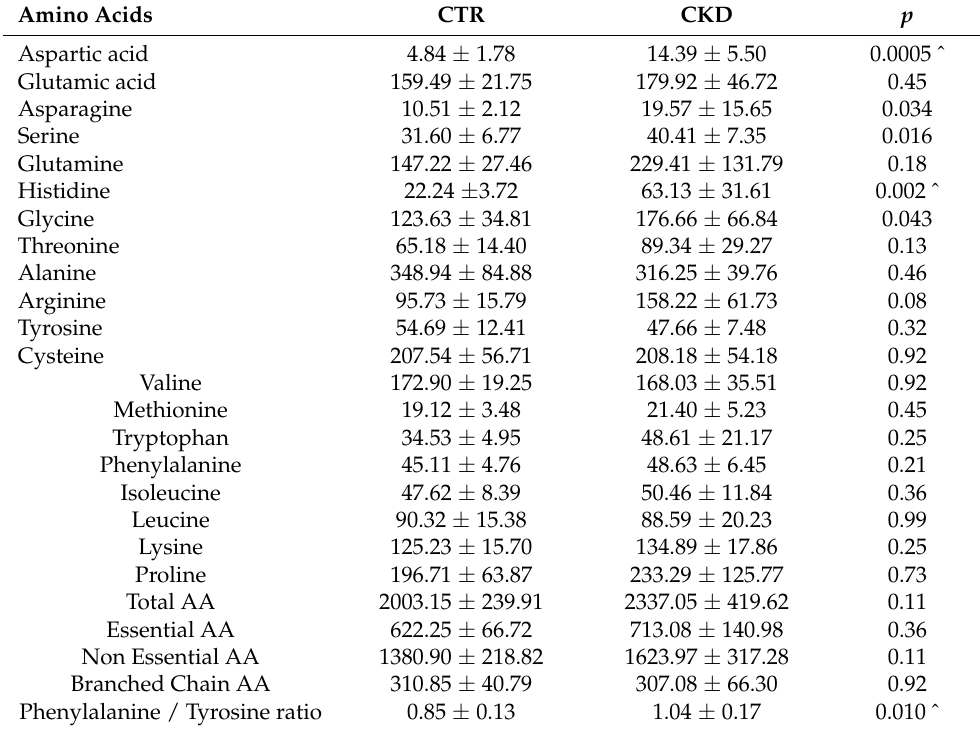
Table 4. Baseline plasma Amino Acid (AA, µ mol/l) profile in controls (CTR) and Chronic Kidney Disease (CKD) patients.